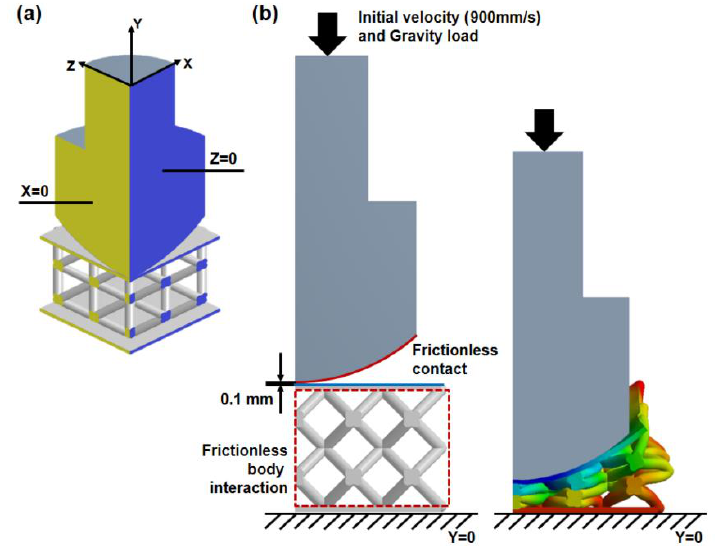
Figure 4. ( a ) Symmetry boundary conditions, and ( b ) loading and contact conditions.